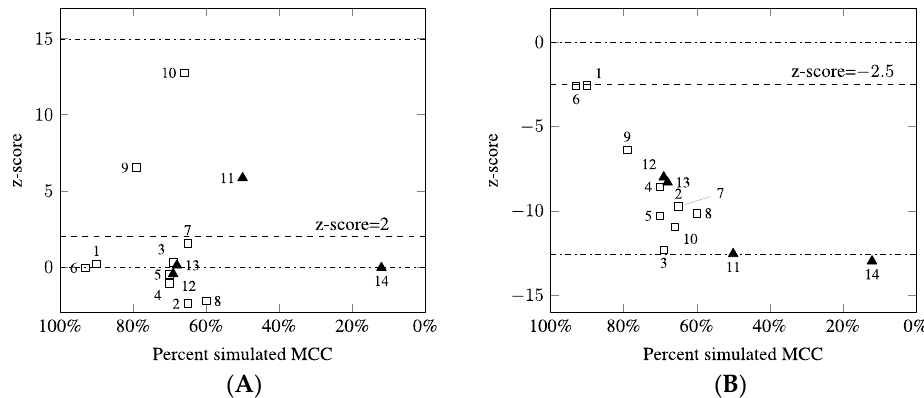
Figure 3. The results of MCC detection in clinical samples using cdPCR. The z-score was plotted against percentage of simulated MCC for ( A ) chromosome 21 and ( B ) chromosome X. For cases 11–14, the percentage shown relates to the mosaic pattern. The squares represent z-scores in clinical samples with MCC; the black triangles represent z-scores in clinical samples with true fetal mosai- cism. Dashed lines indicate the thresholds for the z-scores. Dash-dotted lines represent the mean z- scores for euploid and aneuploid samples.